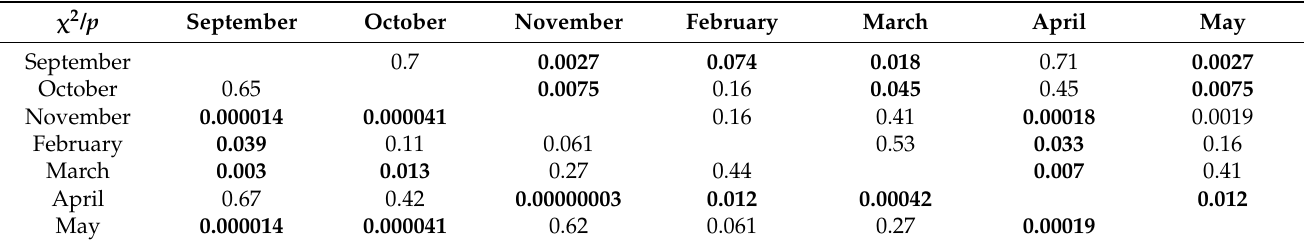
Table 1. Results of χ 2 test and relative p -values; bold indicates statistically significant results.